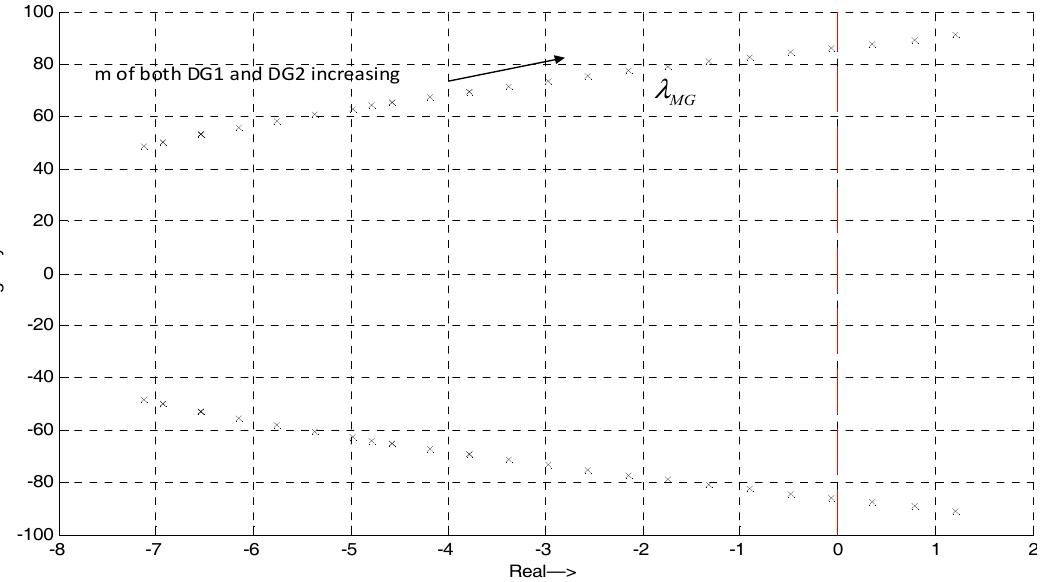
Figure 3. Trace of dominant eigenvalue with increasing the frequency droop gain of both DG1 and DG2 units.